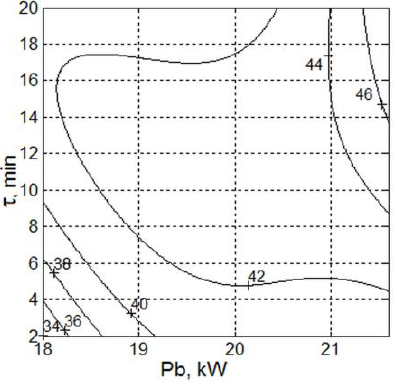
Figure 6. Contour plot of the molten pool diameter d 1 vs. the electron beam power P b and the refining time τ.